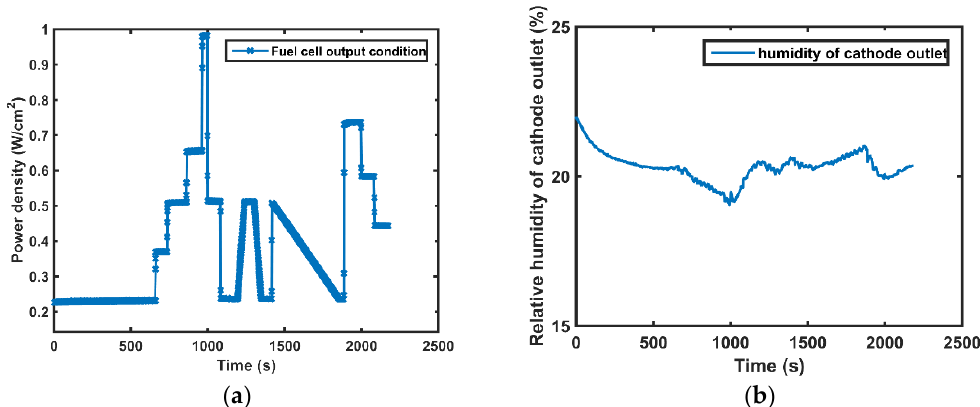
Figure 6. Measurement of relative humidity variation at the cathode: ( a ) power density varied condition; ( b ) relative humidity of cathode.